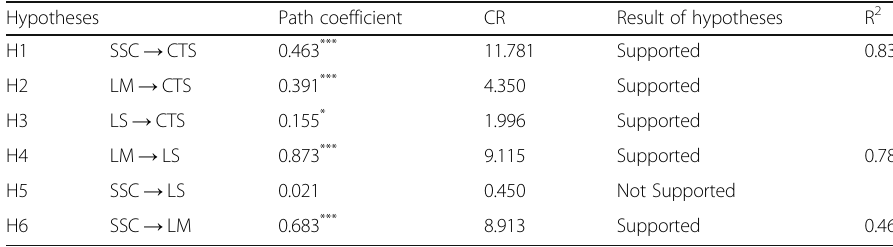
Table 3 Test of hypotheses Hypotheses Path